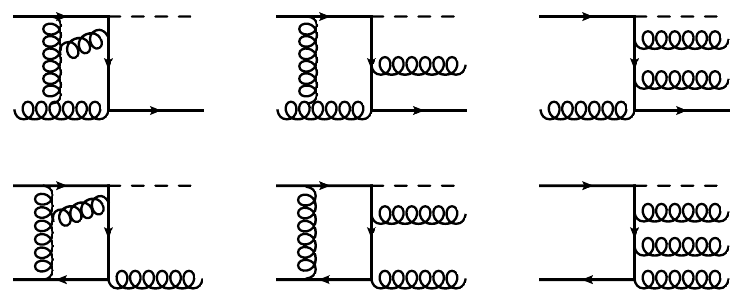
Figure 1 . Top row: representative Feynman diagrams in the 5FS which contribute to the process pp → H + j at NNLO, regardless of b -tagging requirements. Bottom row: representative Feynman diagrams in the 5FS which contribute to the process pp → H + j at NNLO, but fail b -tagging